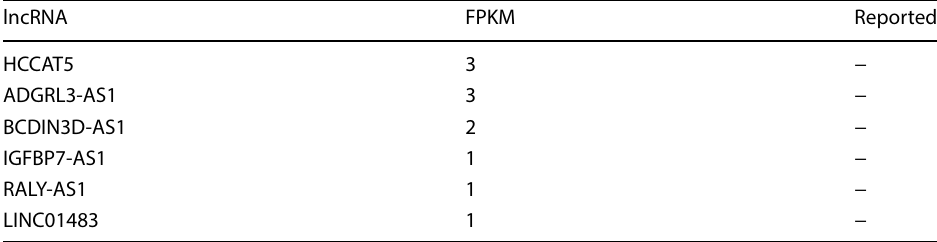
Table 7 Top six treatment- specific lncRNA transcripts in OS-EP compared to OS-P cells